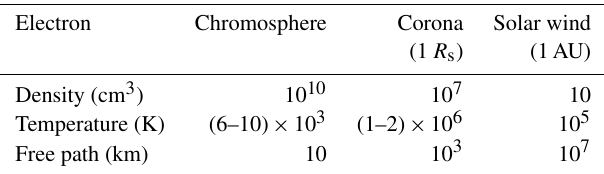
Table 2. Collisionality of the solar atmosphere and